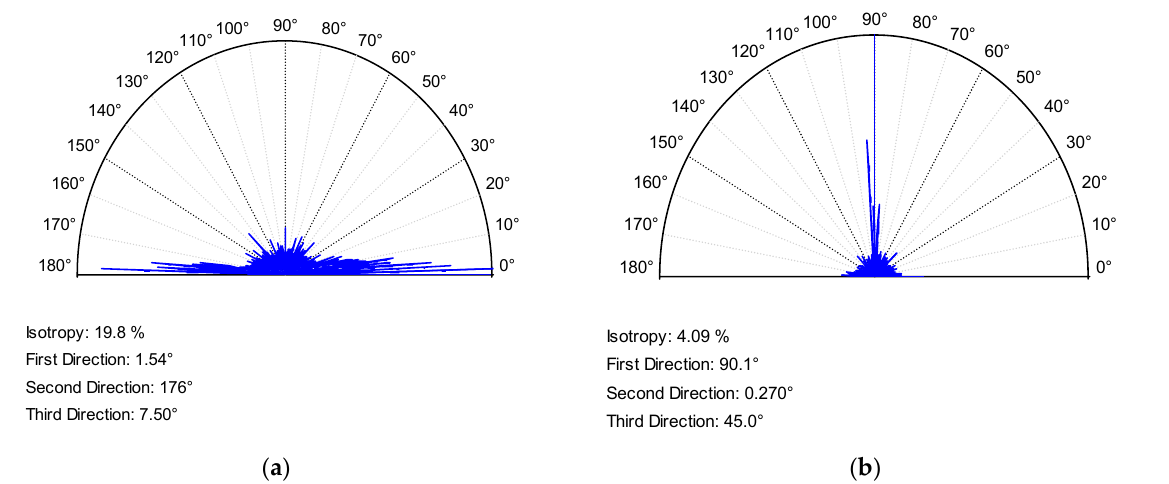
Figure 7. Isotropic rose ( a ) for the base variant and ( b ) after burnishing 𝑃 = 60 N , 𝑓 = 1000 mm/min (experimental run no. 8).